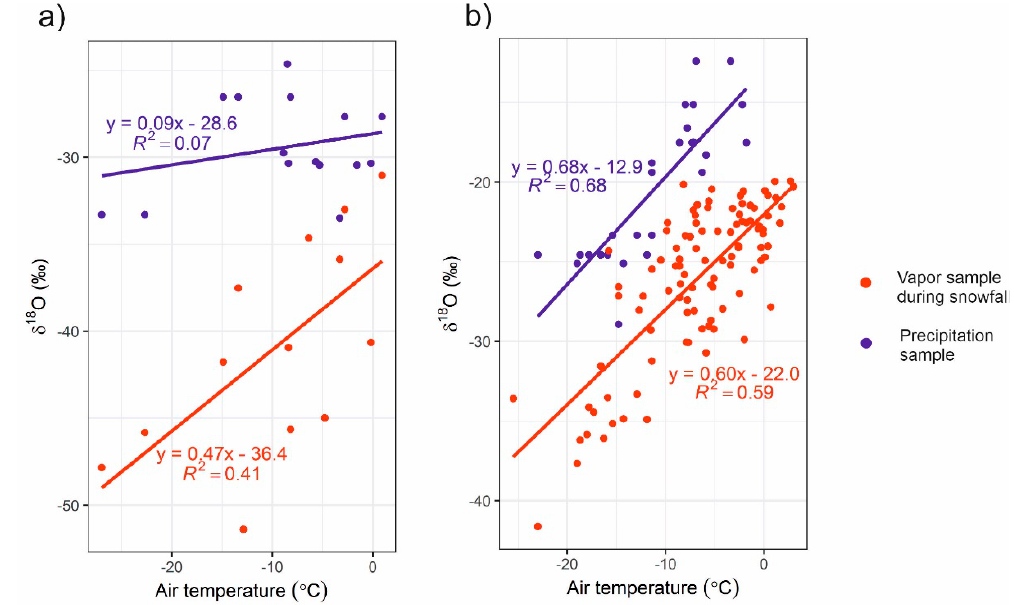
Figure A6. δ 18 O values in snowfall samples and vapor samples during snowfall events as a function of daily average air temperature at ( a ) Pallas and ( b ) Imnavait.